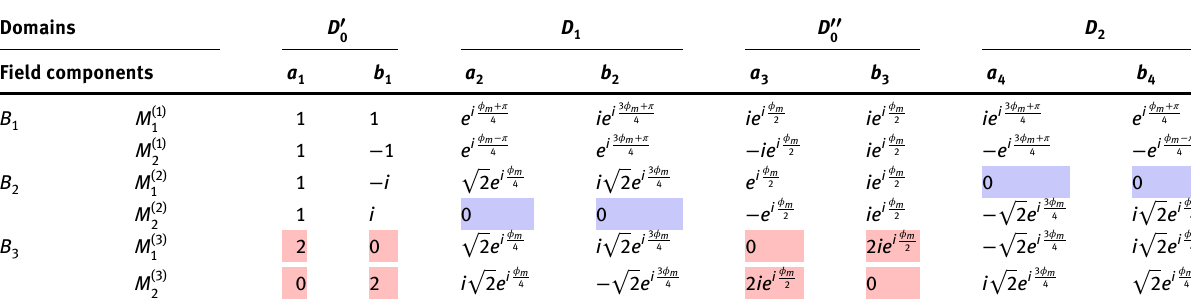
Table 1: Field components associated with the degenerate eigenmodes of the structure shown in Figure 2 as expressed in the three different bases B 1 , 2 , 3